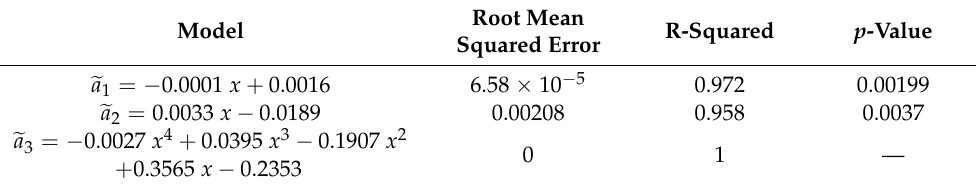
Table 12. Parameters’ models and statistics (procedure 3).